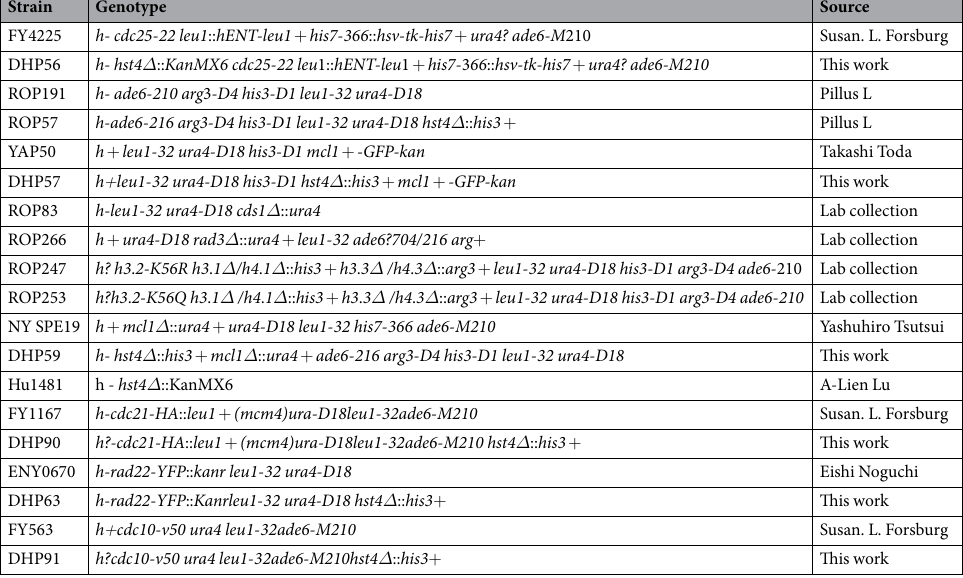
DNA damage treatment of yeast cells.